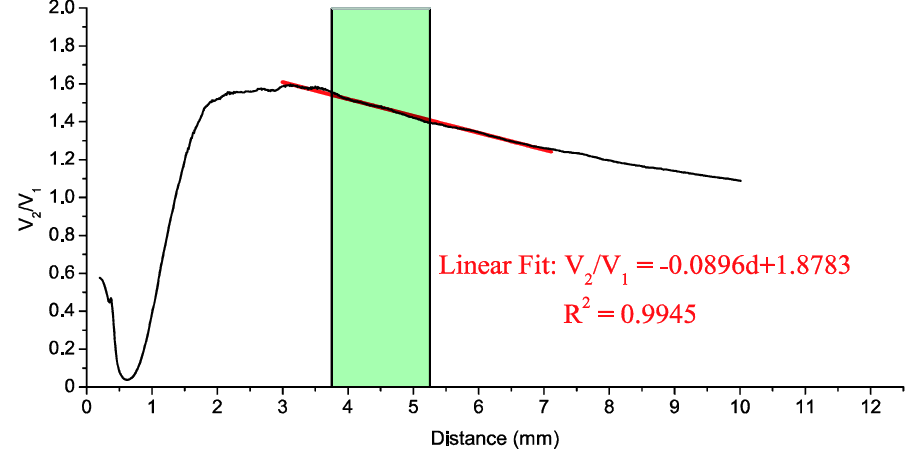
Figure 6. Calibration curve of the optical fiber sensor: quotient of photodetector voltages / V ) as a function of the blade distance ( d ). The red line represents the fit to the ( V 2 1 calibration curve of a straight line in the range 3–7 mm. The shaded area corresponds to usual values of the TC (without